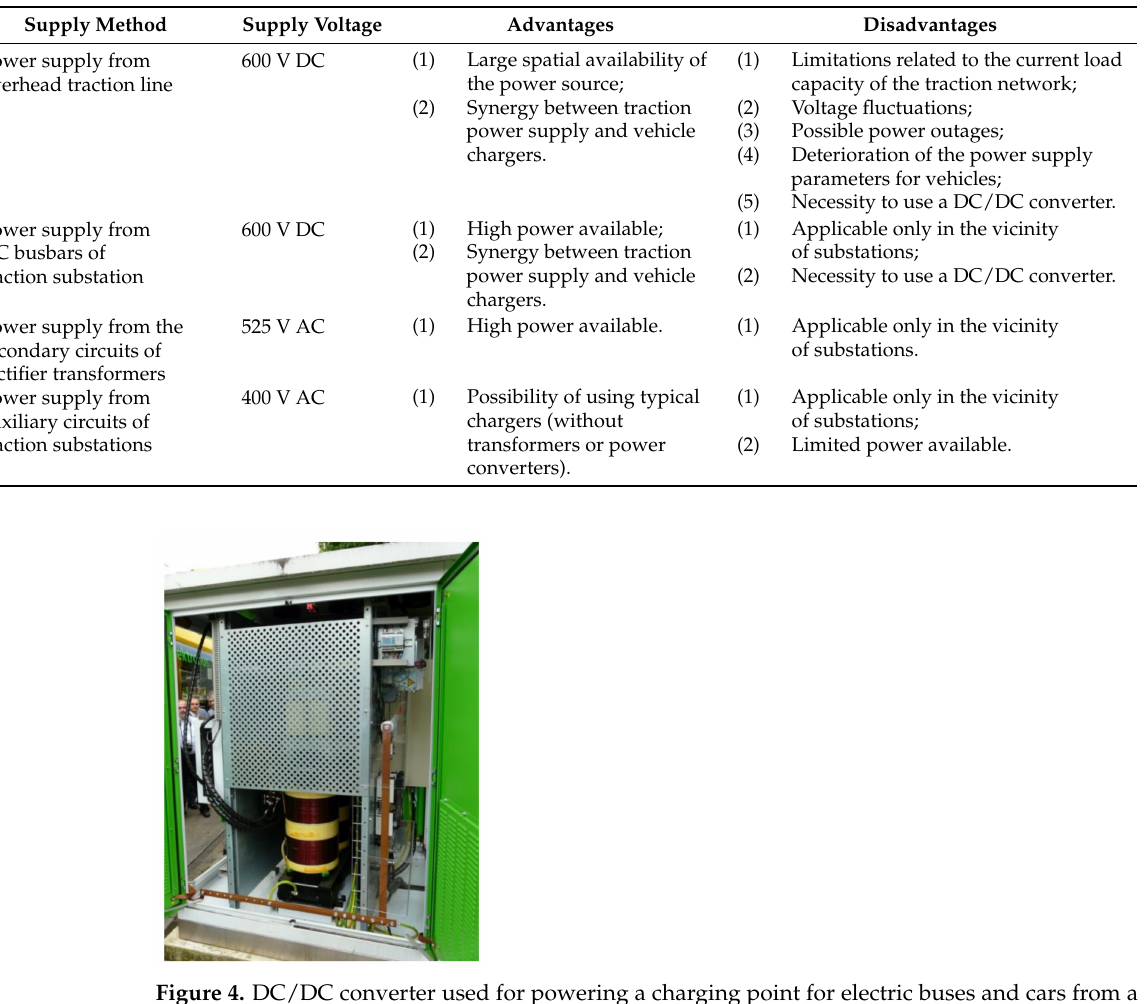
Figure 3. Charging station for electric bus and electric cars powered from the tram overhead line in Oberhausen, Germany. Table 1. Comparison of the possibilities of supplying electric vehicle charging stations from traction power system.